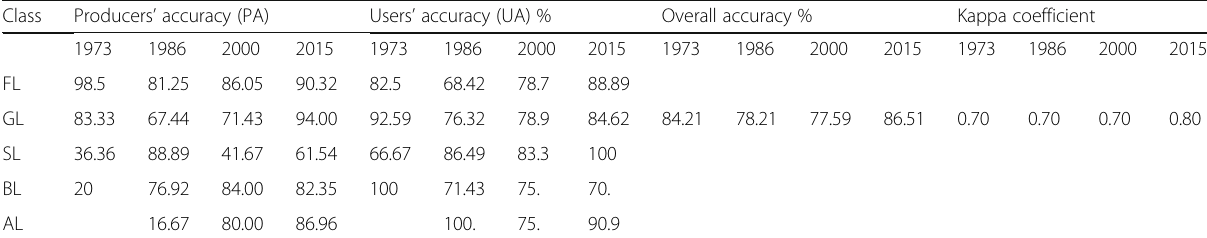
Table 6 Summary of the error matrices of classification accuracies of 1973, 1986, 2000, and 2015 in Sidama, South